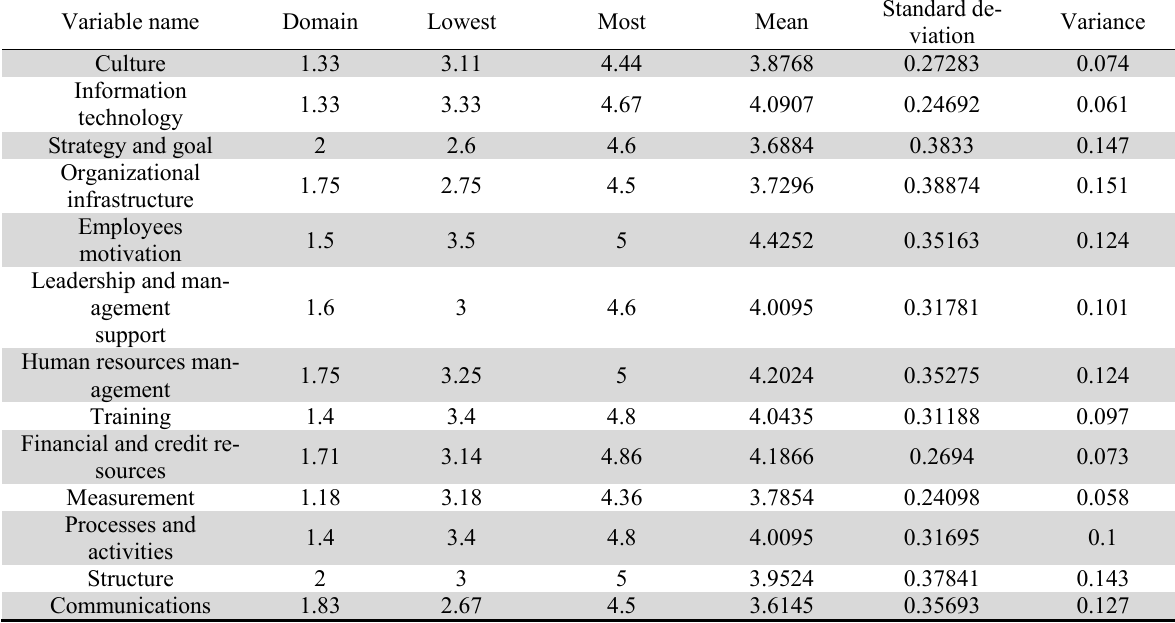
Frequency distribution of descriptive statistics indexes of success factors of using